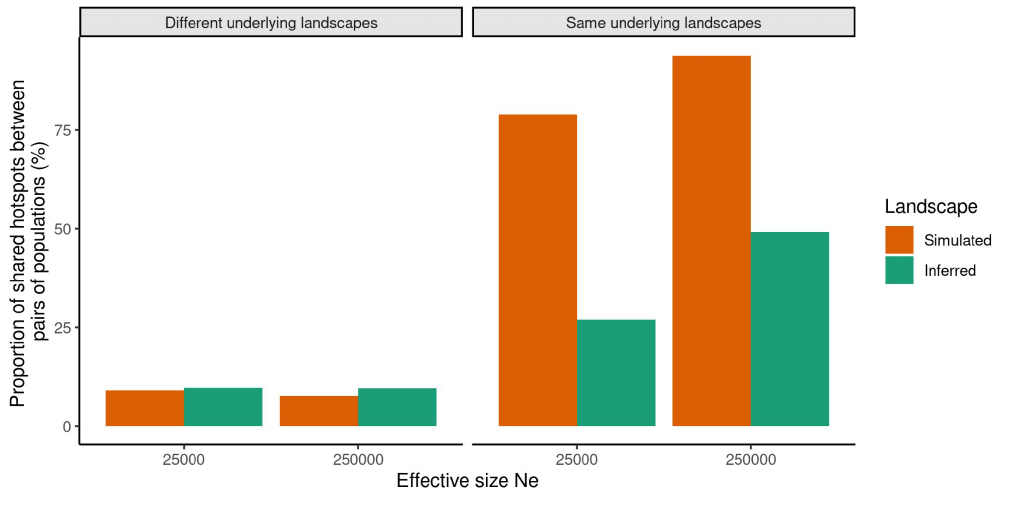
Figure 7 - Expected and observed hotspot sharing between populations with different (left panel, following simulation framework from Supplementary Figure S3A) or identical (right panel, following simulation framework from Supplementary Figure S3B) underlying landscapes. Mean proportion of shared hotspots between pairs of simulated (expected proportion, orange bars) and pairs of inferred (observed proportion, green bars) recombination landscapes as a function of N e ( i.e. 25,000 and 250,000, x axis). Only shown here are simulations with SS = 20, BP = 5, hotspots detection threshold = 2.5. The proportion of shared simulated and inferred hotspots for all combinations of parameters and for populations sharing or not the same underlying landscape are shown in Supplementary Table